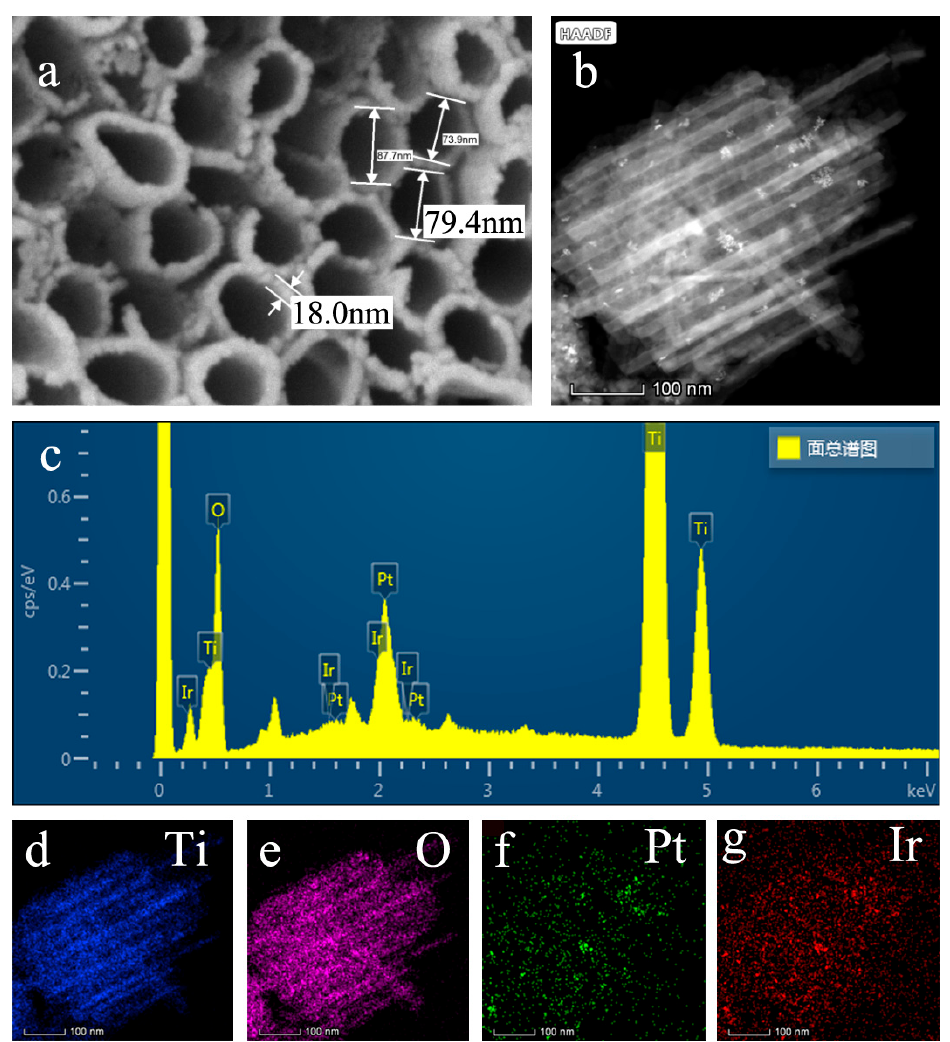
Figure 2. ( a ) Top-view SEM of TiO 2 NTs; ( b ) The TEM image of Pt-IrO 2 / TiO 2 NTs / Ti; ( c ) The EDS of Pt-IrO 2 / TiO 2 NTs / Ti; ( d – g ) The EDS mappings of Pt-IrO 2 / TiO 2 NTs / Ti.